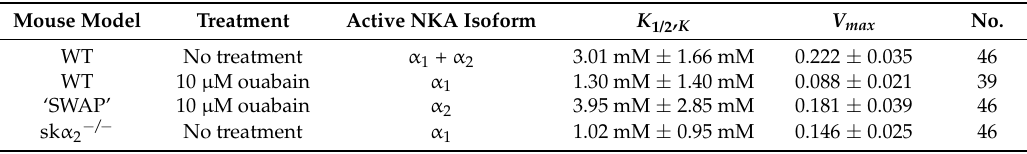
Figure 7. Apparent K + affinities of α 1 and α 2 isozymes of Na,K-ATPase obtained from measurements of tracer Rb + uptake in EDL fibers of WT, ‘SWAP’ and sk α 2 − / − mice. Samples of 2–5 fibers were incubated for four min in uptake buffer containing 0 to 20 mM [K + ] o and 500 µM RbCl, and washed as described in Figure 2. The samples were pre-incubated for 5 min in Rb + and K + free buffer containing 0, 10 µM, or 2 mM ouabain. Total Rb + content is normalized to the P content of each sample. ( a ) K + dependence of Rb + uptake in WT fibers in the absence (both α 1 + α 2 remain active) and presence of 2 mM ouabain (no active Na,K-ATPase isoform). N = 46 and 41 samples, respectively; ( b ) K + dependence of Rb + uptake in WT or ‘SWAP’ fibers in the presence of 10 µM ouabain ( α 1 is active in WT, α 2 is active in ‘SWAP’; n = 39 and 46 samples, respectively); ( c ) K + dependence of Rb + uptake in WT and sk α 2 − / − fibers ±2 mM ouabain ( α 1 only, at 2–3-fold increased abundance). N = 46 and 46 samples, respectively. Note: the curve for WT in 7c is the same as 7a and is superimposed on sk α 2 − / − data for comparison; ( d , e ) K 1/2 ,K and V max for each genotype, obtained from a fit of the data sets in a–c to the Michaelis–Menten equation. Table 3. Summary of K 1/2 ,K and V max obtained from measurements of specific α 1 or α 2 activity.